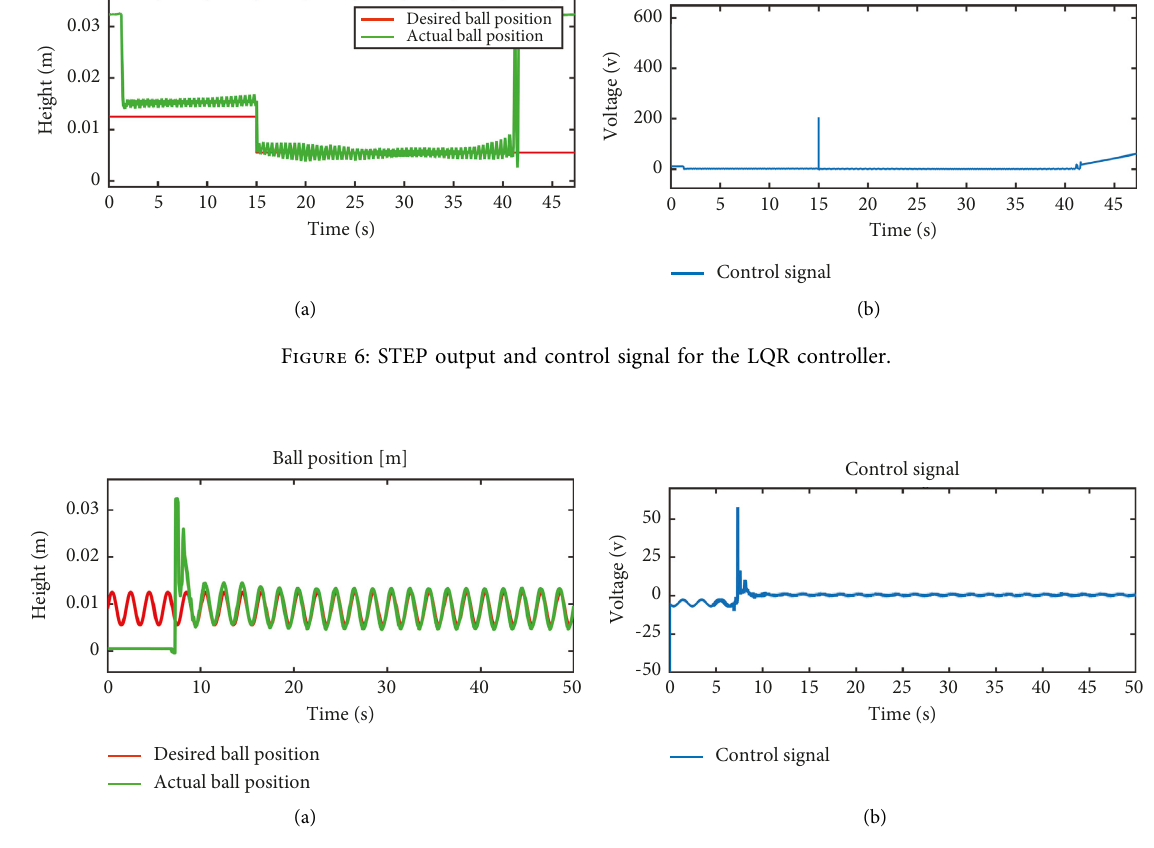
Figure 7: SINE output and control signal for the LQR controller.